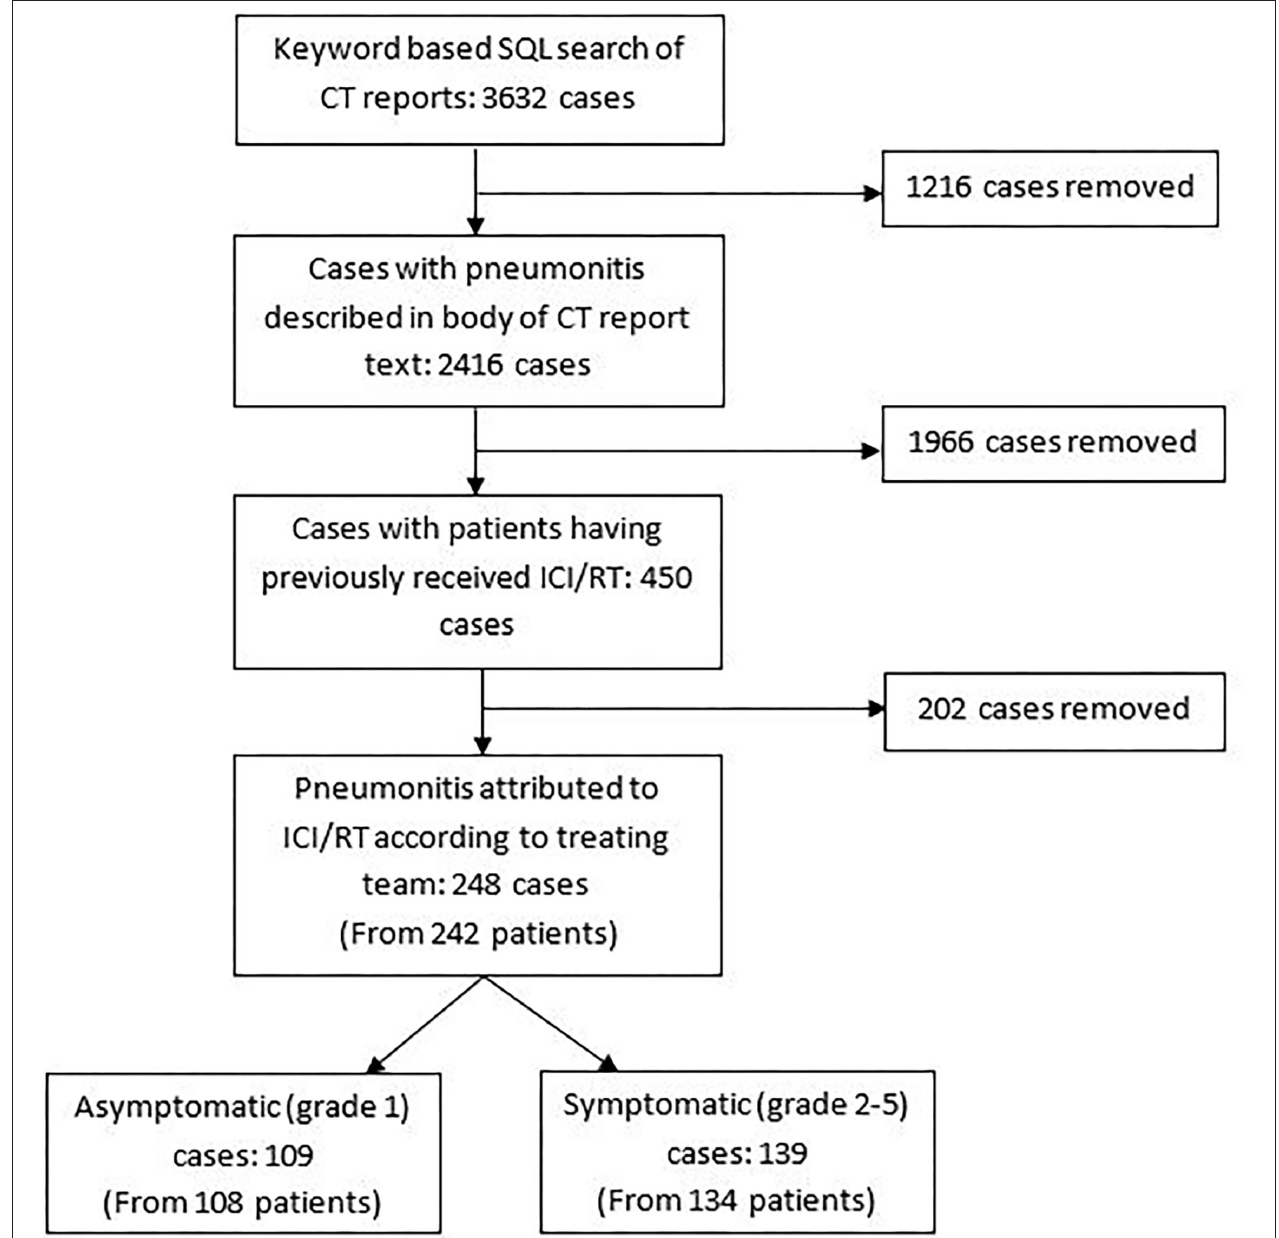
FIGURE 1 | Flow of data to identify cases for inclusion. RT,